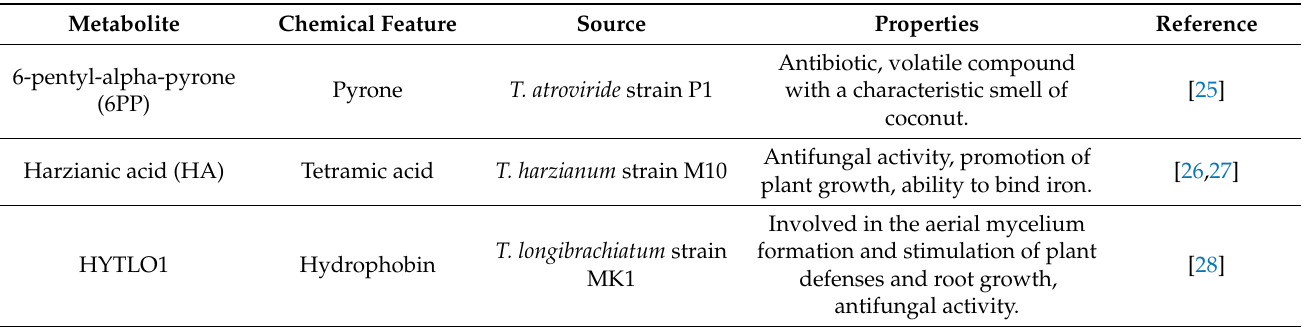
Table 3. Trichoderma bioactive metabolites (BAMs) used in this